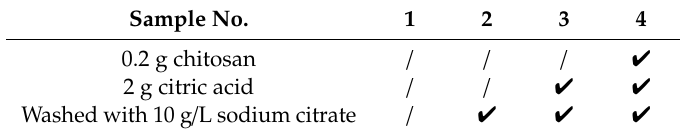
Table 1. Treatment chemicals used for the 4 fabrics treated under di ff erent conditions before dyeing with SCC. Sample